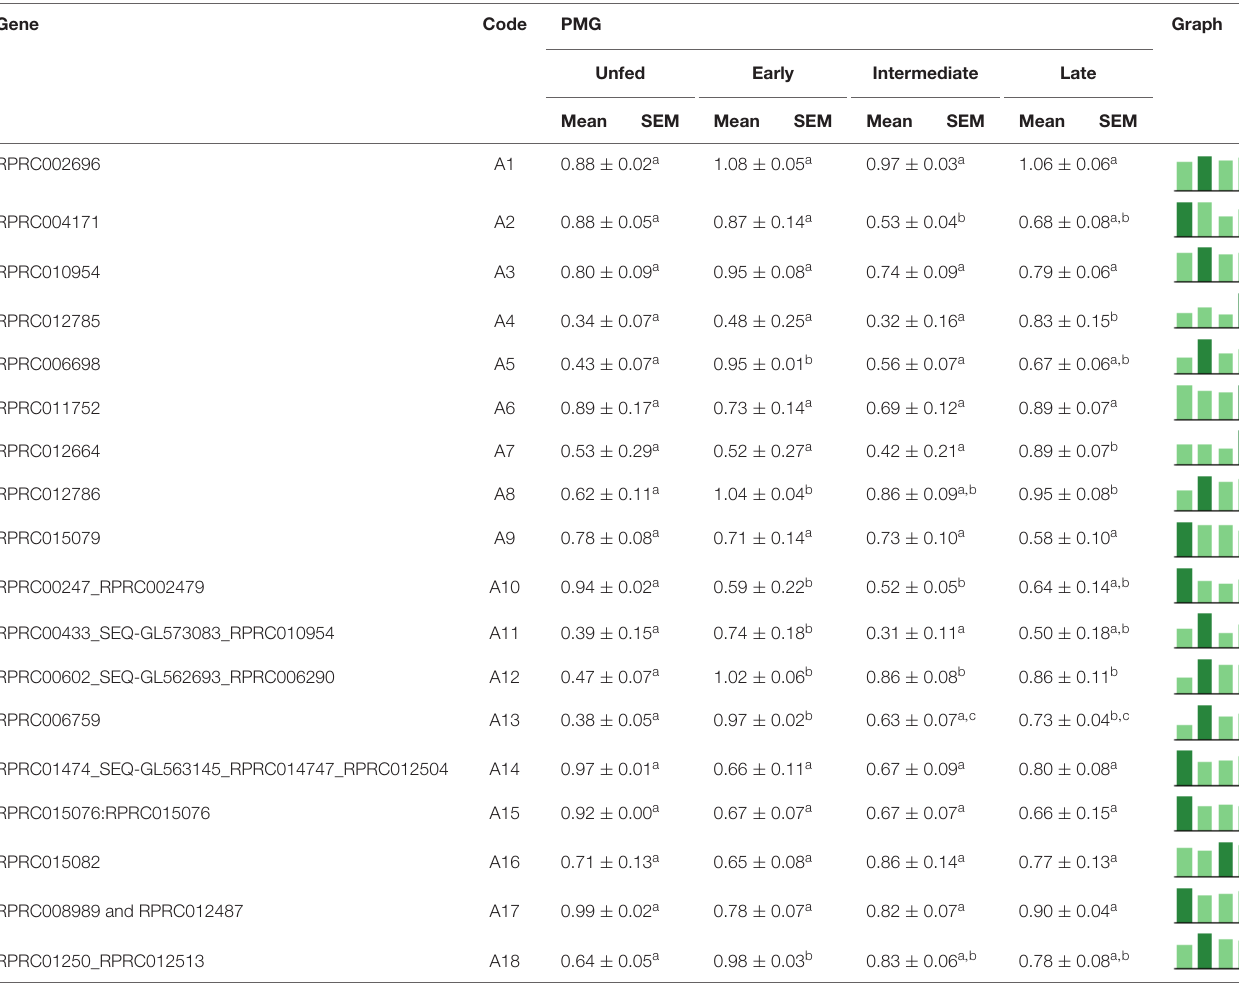
Figures are means ± SEM from three amplification determinations using cDNA pool preparations of six insect samples each. In a dataset, groups with the same superscript letter are not significantly different (p ≥ 0.05). In the miniature graphs, differently colored bars highlight the highest expression levels. Statistical analysis consisted of ordinary two-way ANOVA with Tukey’s multiple-comparisons